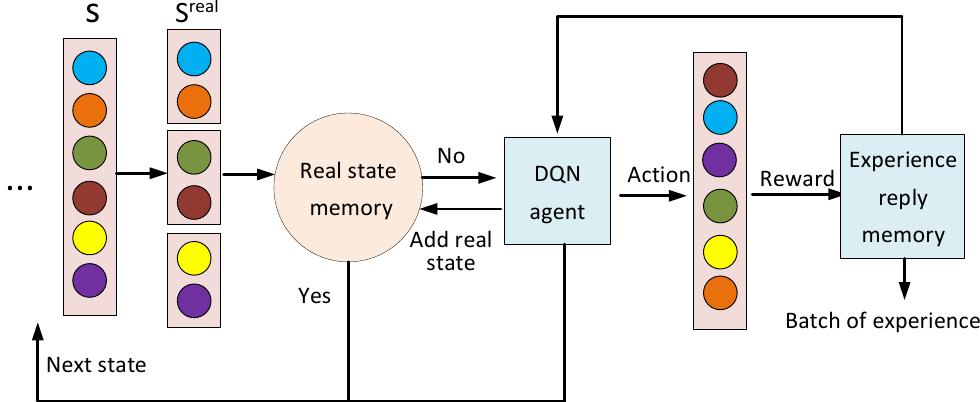
Figure 3. The workflow of